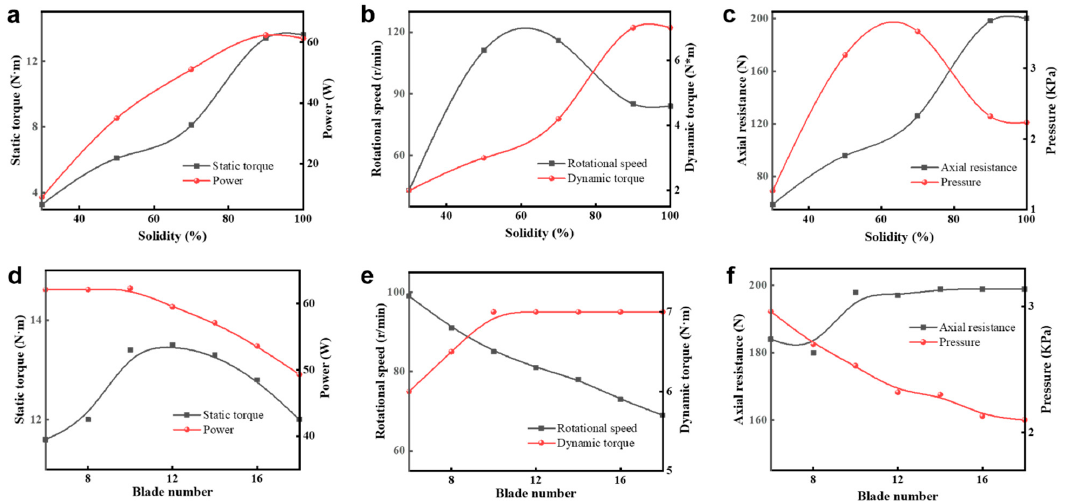
Figure 9. ( a ) Static torque and power relationship with solidity; ( b ) rotational speed and dynamic torque relationship with solidity; ( c ) axial resistance and dynamic pressure relationship with solidity; ( d ) static torque and power relationship with blade number; ( e ) rotational speed and dynamic torque relationship with blade number; ( f ) axial resistance and dynamic pressure relationship with blade number.